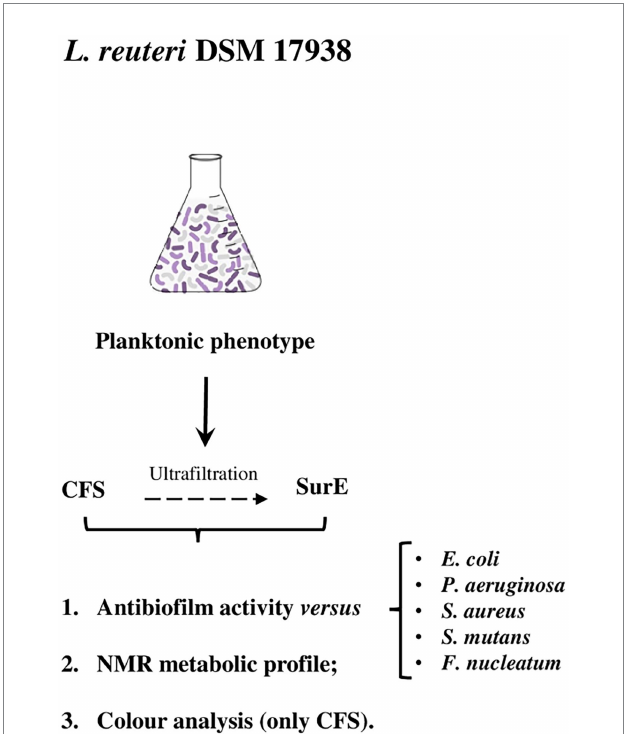
FIGURE 1 Flowchart of this study. CFS, cell-free supernatant; SurE, eluted supernatant <10